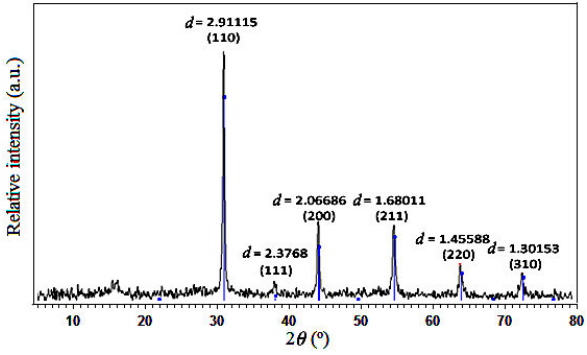
Fig. 1 XRD pattern for BaSnO 3